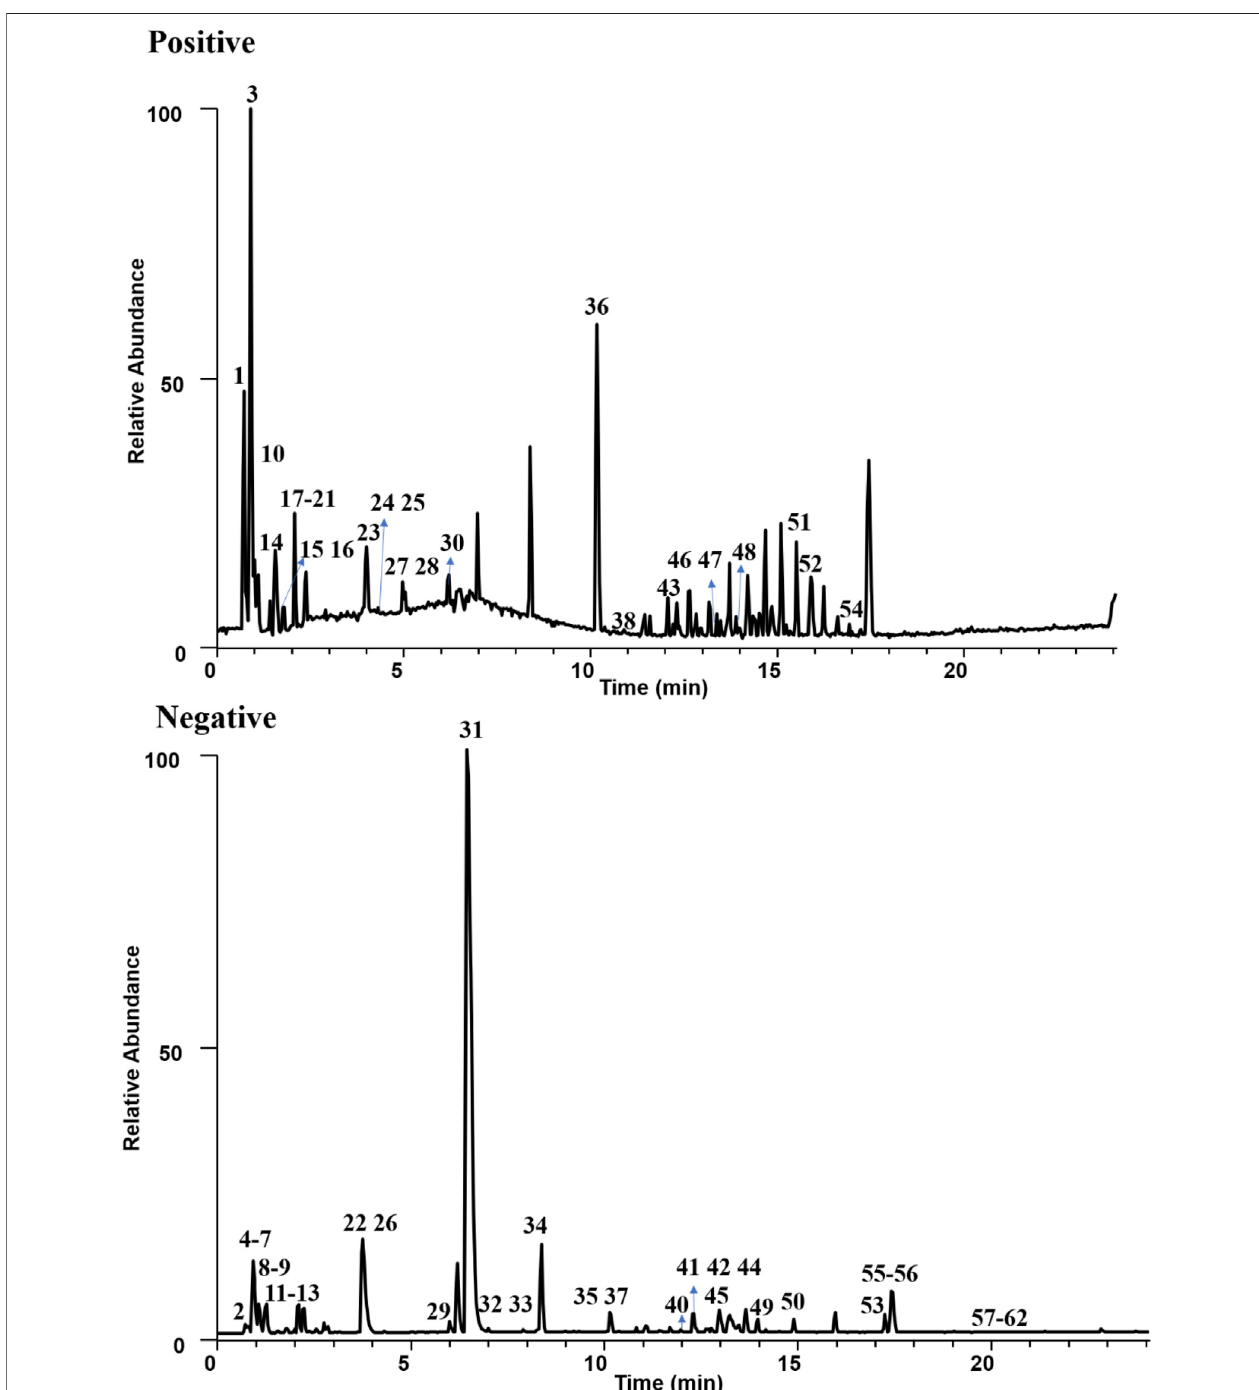
FIGURE 1 | Total ion chromatography of GAO